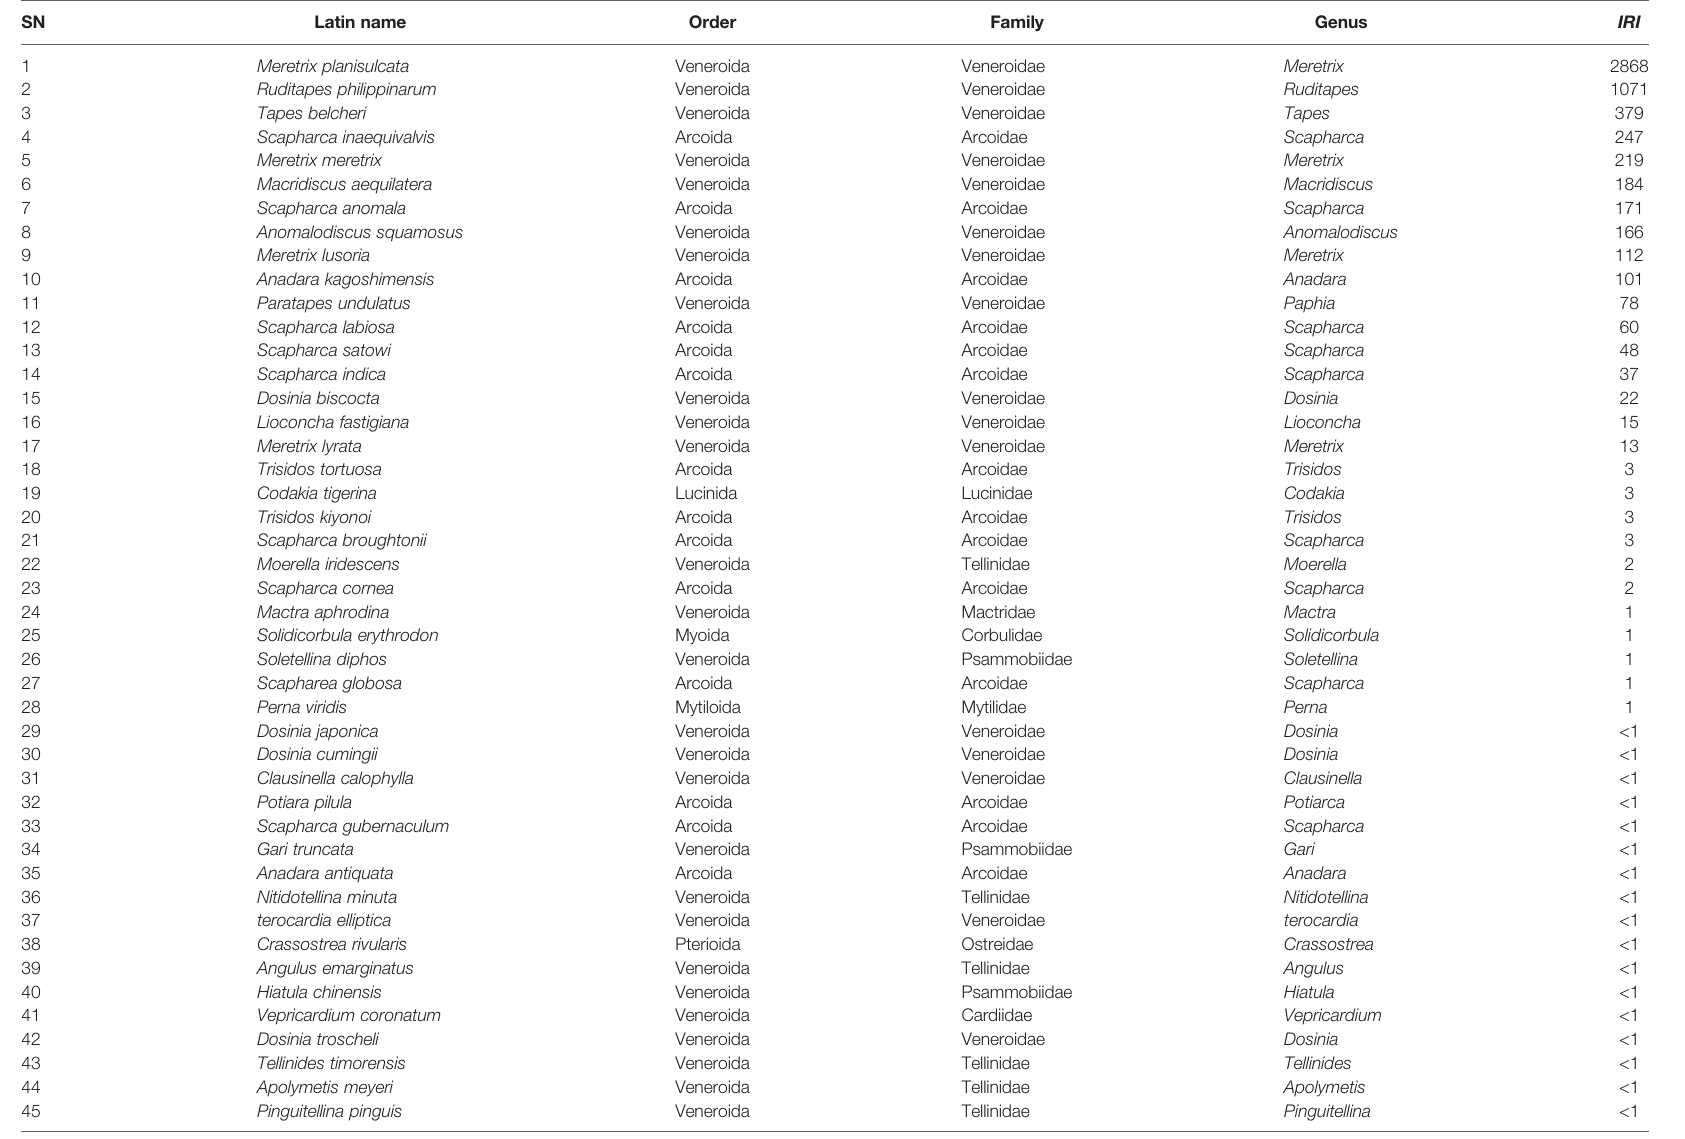
TABLE 1 | Species composition and IRI values of bivalves from Maoming shallow waters in November 2020.